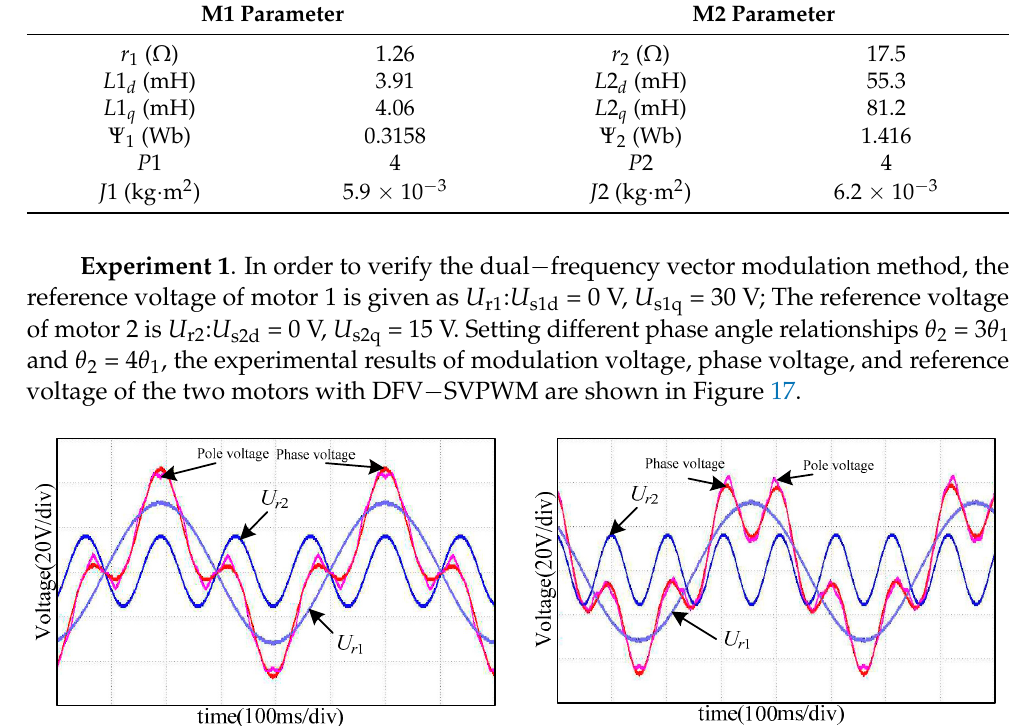
( b ) Figure 18. The voltage a speed waveform of voltage open − loop control based on DFV − SVPWM: ( a ) steady state; ( b ) dynamic state. From Figure 18, it can be seen that both motors can run smoothly with a given voltage. This also verifies the validity of the voltage decoupling of two motors in a time(500ms/div)Speed2 Speed1 Output voltage 0